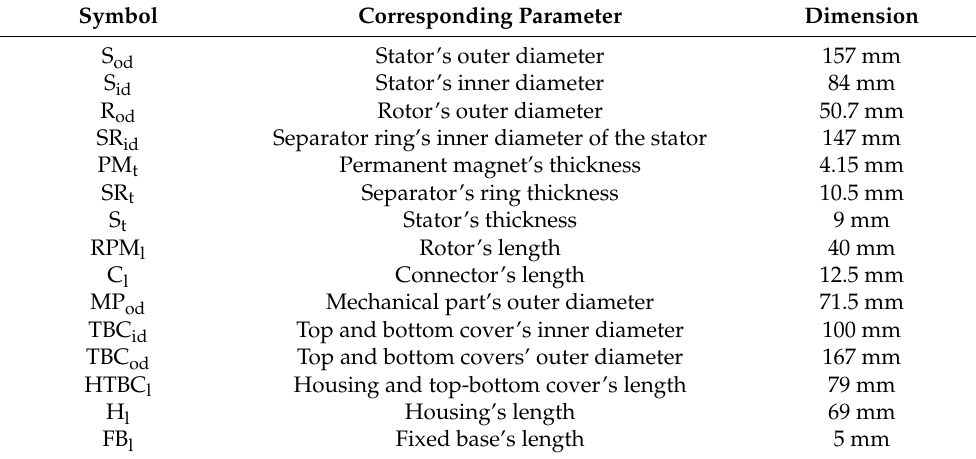
Table 1. Design parameters of the motor.